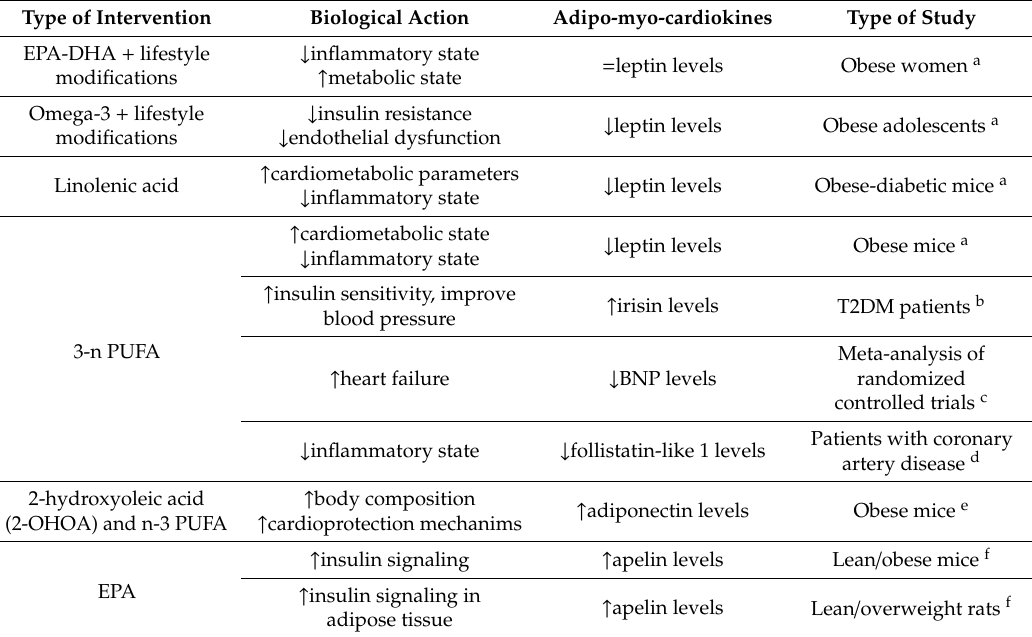
Table 3. E ff ects of 3-n PUFA supplementation on adipokines, myokines, and